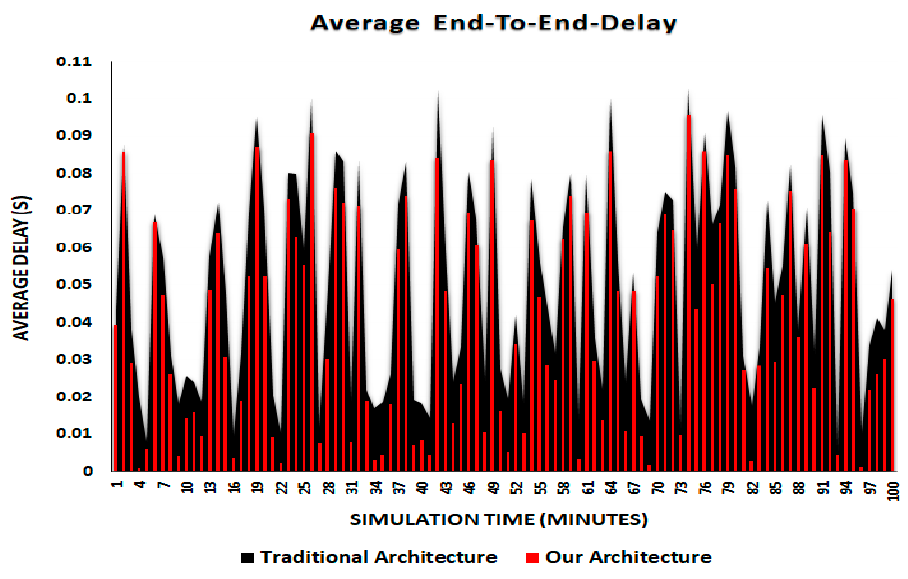
Figure 8. Percentages of end-to-end delay.